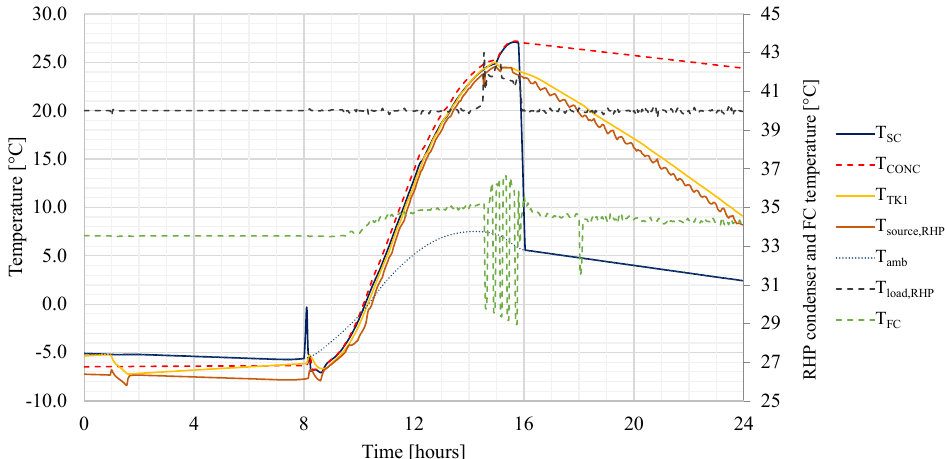
Figure 5. Temperatures of the working fluids at the outlet of the main components and the ambient air temperature, winter day.